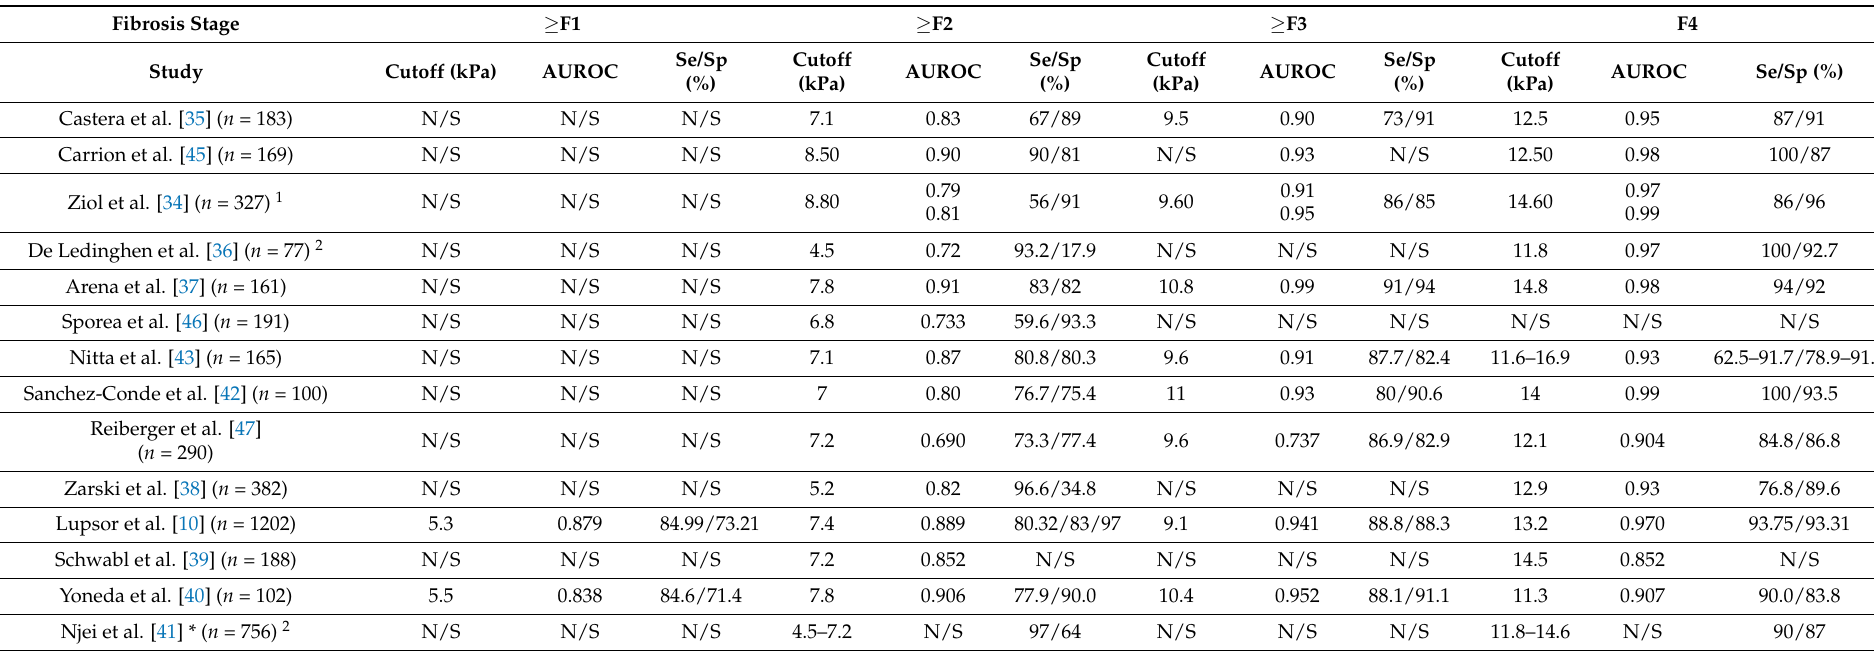
Table 1. Performance of LS cutoff values by VCTE for predicting moderate fibrosis ( ≥ F1), significant fibrosis ( ≥ F2), advanced fibrosis ( ≥ F3), and cirrhosis (F4) in chronic HCV infected